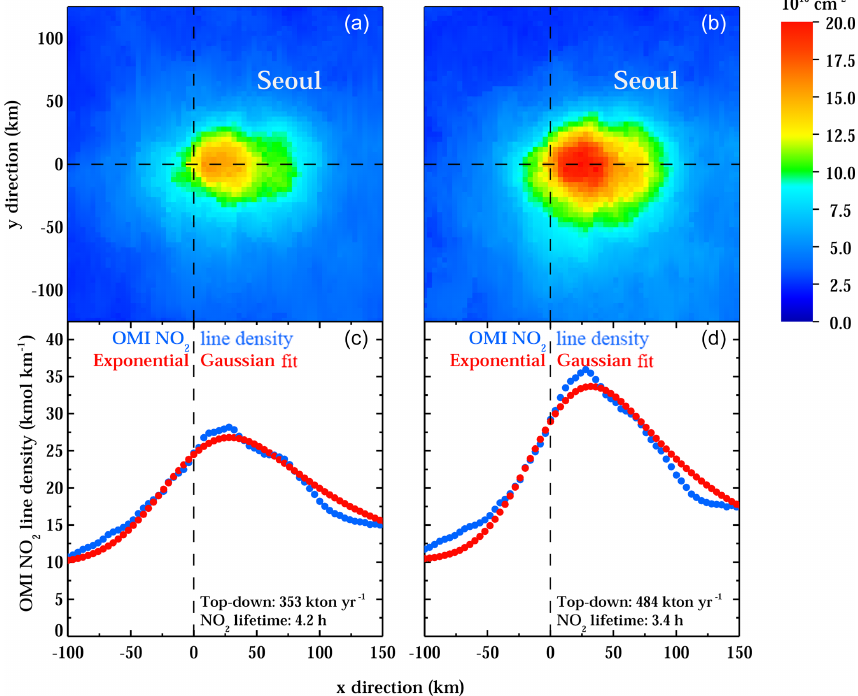
Figure 8. Panels (a) and (b) represent the oversampled (4km × 4km) OMI NO 2 plume from Seoul rotated based on wind direction over a 9-month period, April–June 2015–2017, centered on May 2016. Panels (c) and (d) represent the OMI NO 2 line densities integrating over the 240km across-plume width ( − 120 to 120km along the y axis of a, b ) and the corresponding EMG fit. Panels (a) and (c) are from the OMI-standard NO 2 product and (b) and (d) are from the OMI-regional NO 2 product. NO x emissions estimates are shown in units of ktyr − 1 NO 2 equivalent and represent the midafternoon emissions